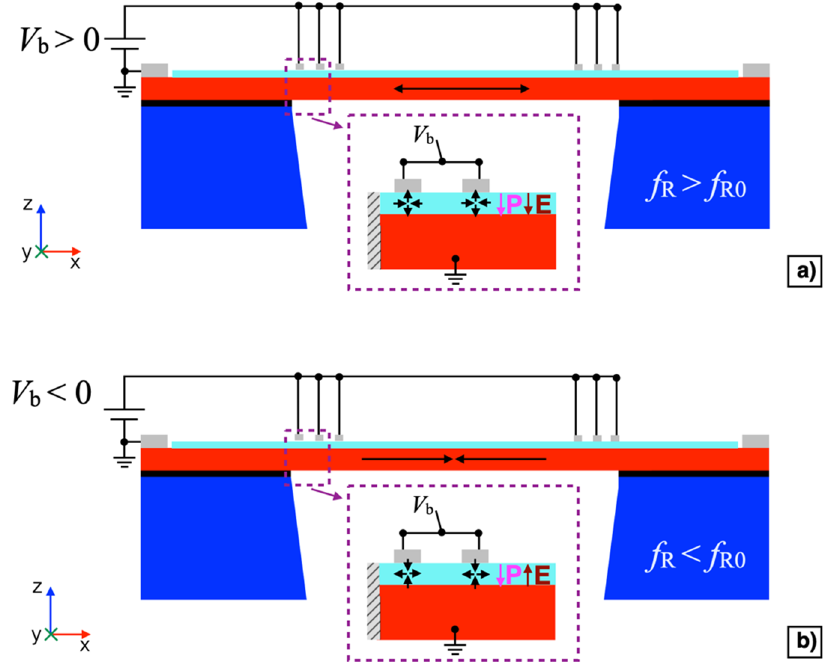
Figure 5. Cross-sectional view of the piezoelectric MEMS device with positive ( V b > 0 V) ( a ) and negative ( V b < 0 V) ( b ) bias voltage.